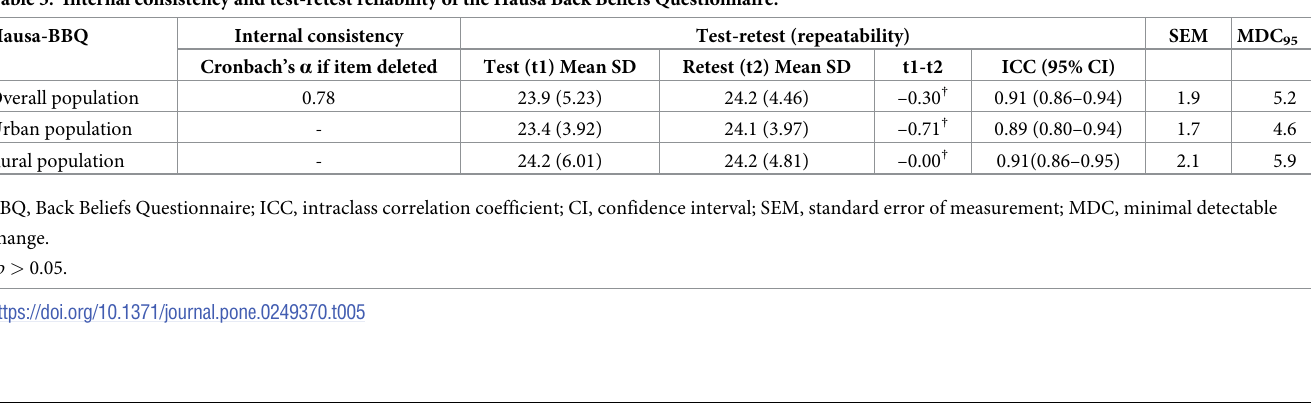
Table 5. Internal consistency and test-retest reliability of the Hausa Back Beliefs Questionnaire. Hausa-BBQ